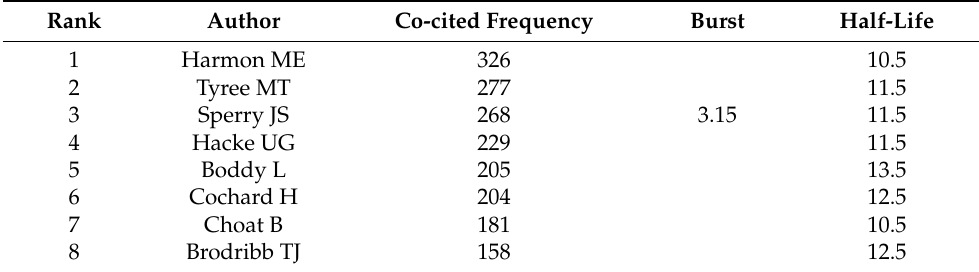
Table 4. The index information of the crucial author.